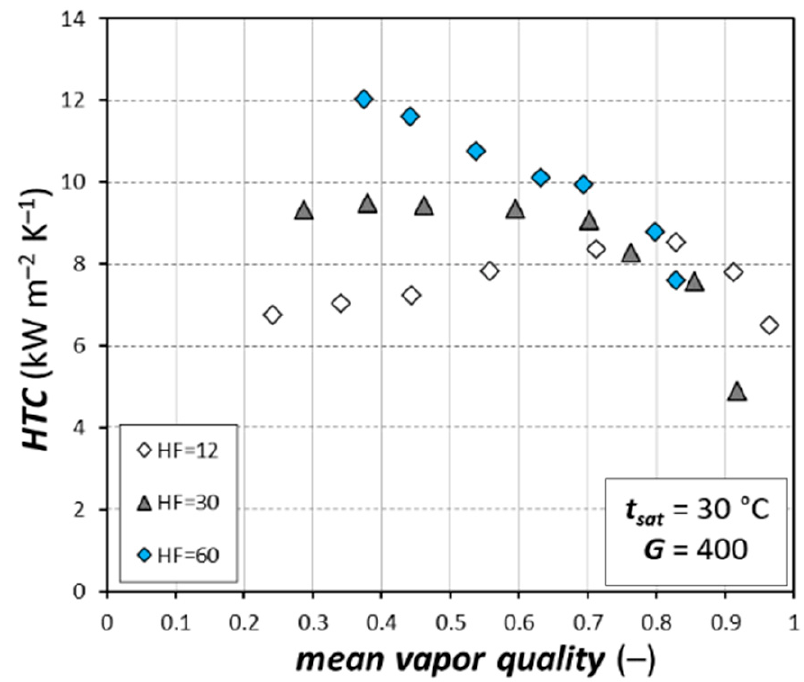
Figure 4. Heat transfer coefficient versus mean vapor quality at t sat = 30 ◦ C and G = 400 kg m − 2 s − 1 at different heat fluxes. HF expressed in (kW m − 2 ).